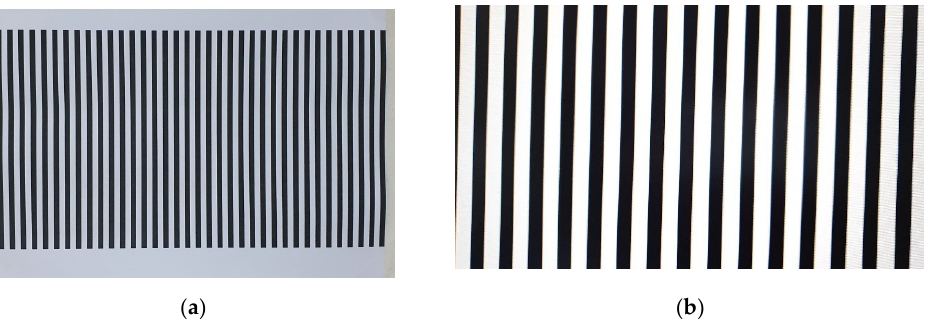
Figure 6. RSE occurrence test result: ( a ) the test site and ( b ) the image taken when the camera moves parallel to the image plane.